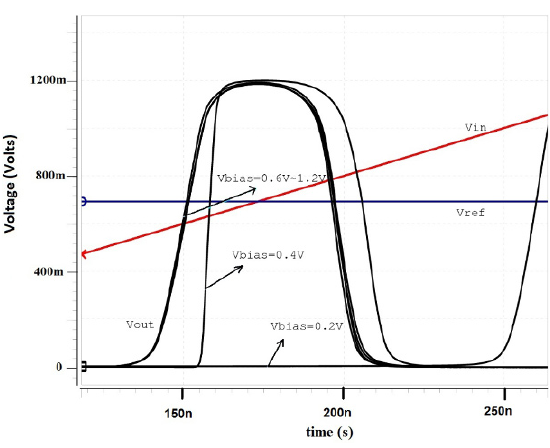
Figure 3. Static response of the decision circuit.